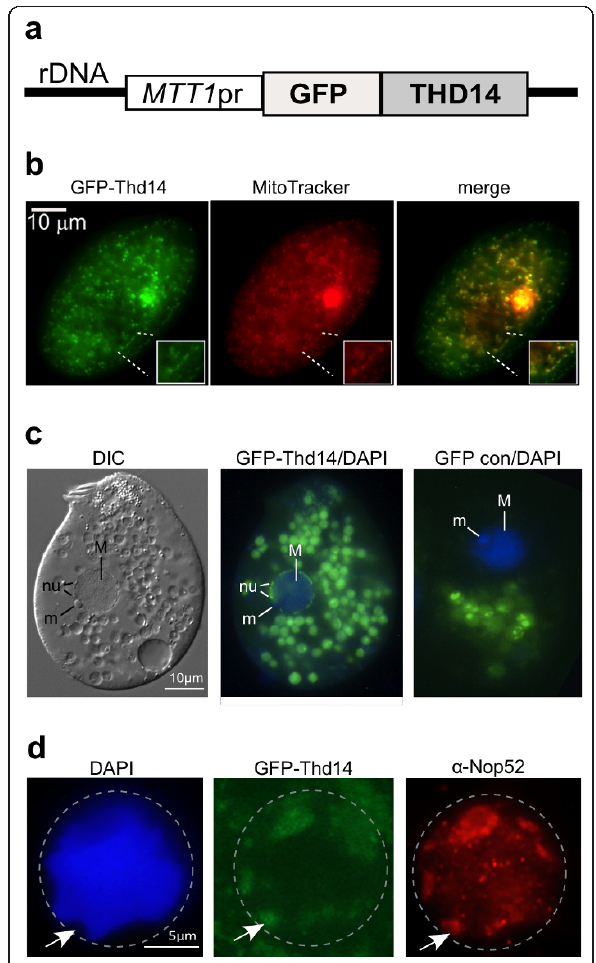
Figure 6 Thd14 resides in mitochondria and nucleoli during growth . a Line drawing schematic of the construct engineered on an rDNA vector for expression of GFP-Thd14 fusion protein from the metallothioneine promoter ( MTT1 pr). During conjugation, the vector is processed and amplified as a small linear rDNA chromosome. b Fluorescence microscopy image of a live cell showing GFP-Thd14 localizing to mitochondria (stained with Mitotracker) near the surface of the cell. Inlays show magnification of one mitochondrial- dense region. The larger region of intense staining is rarely observed in other cells and thus considered an artifact. c Differential interference contrast (DIC) imaging of a live cell in vegetative growth shows locations of nuclear structures, including the micronucleus (m) and multiple nucleoli (nu) positioned around the macronuclear (M) periphery. Fluorescence microscopy shows a merge of DAPI imaging with GFP-Thd14 in nucleoli (center panel). “ GFP con/DAPI ” is the GFP only control (no fusion) with a DAPI image overlay. Green spheres outside the nucleus are probably food vacuoles, a common artifact observed with high GFP-protein expression. Live cells were concentrated and mounted in 2% methylcellulose for observation. d Fluorescence microscopy on a paraformaldehyde-fixed cell nucleus (bounded by dashed circle) showing co-localization of GFP-Thd14 and Nop52 by immunofluorescence in regions staining poorly with DAPI (arrow indicates an